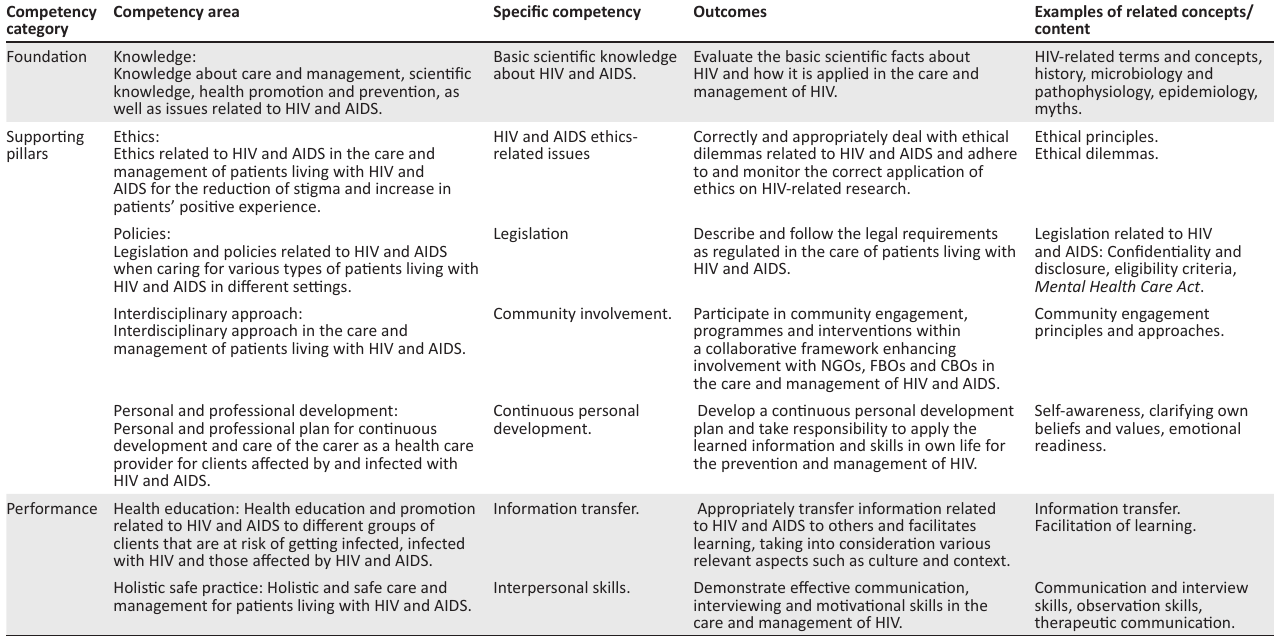
TABLE 3: A sample of HIV and AIDS nursing competency statement, specific competency, outcomes and related